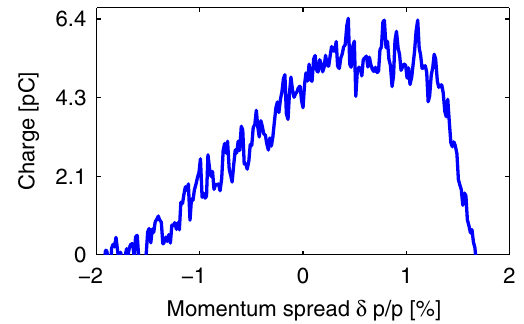
FIG. 7. The momentum distribution of the beam as measured at